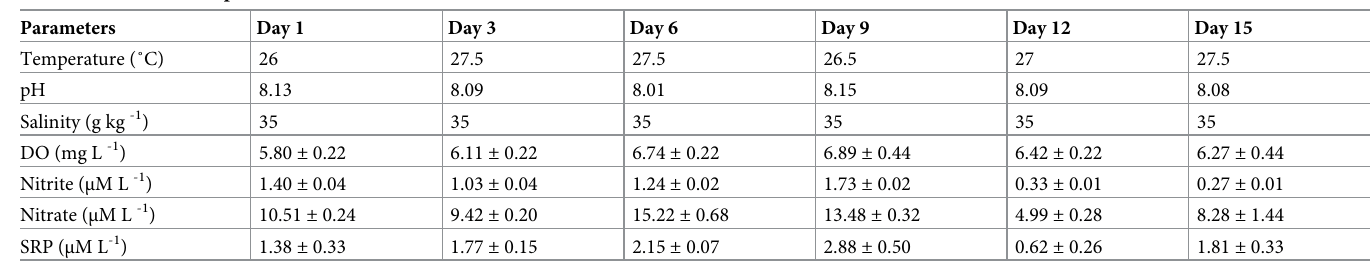
Table 1. Environmental parameters and nutrients content of seawater.